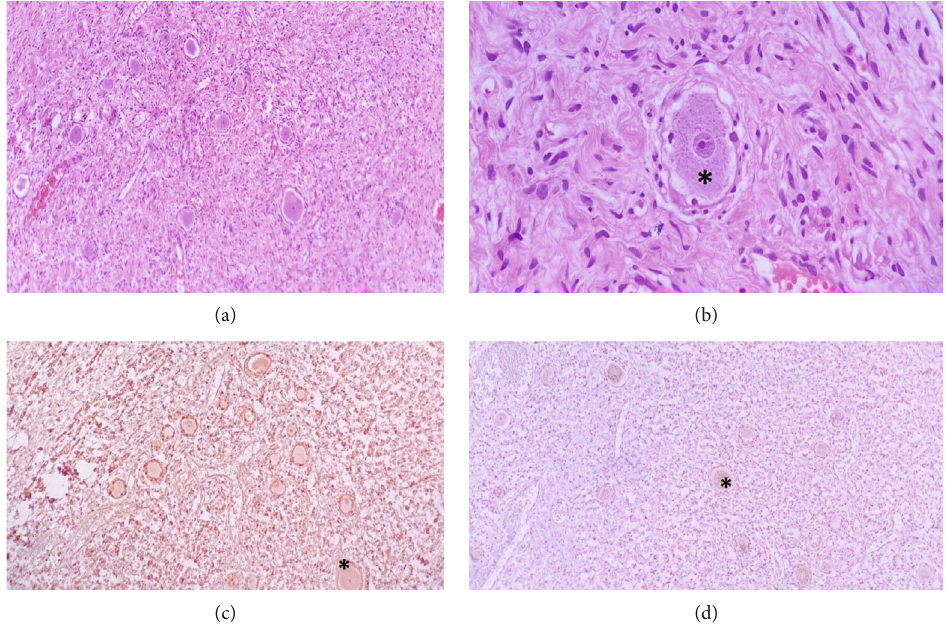
Figure 8: Histopathology of the tumor. (a, b) Histopathological sections of the tumor show bipopulation of the tumor cells, sheet of spindle shape bland looking cells mixed with scattered large spherical ganglion cells ( ∗ ). Neither necrosis nor mitosis is seen in the tumor ( × 100, × 400, hematoxylin and eosin). (c) Immunohistochemical stain for S-100 shows di ff use, strong immunopositivity in both neuroma and ganglion cell component ( ∗ ) ( × 100). (d) Immunohistochemical stain for chromogranin shows immunostaining in ganglion cell component ( ∗ ) only ( ×